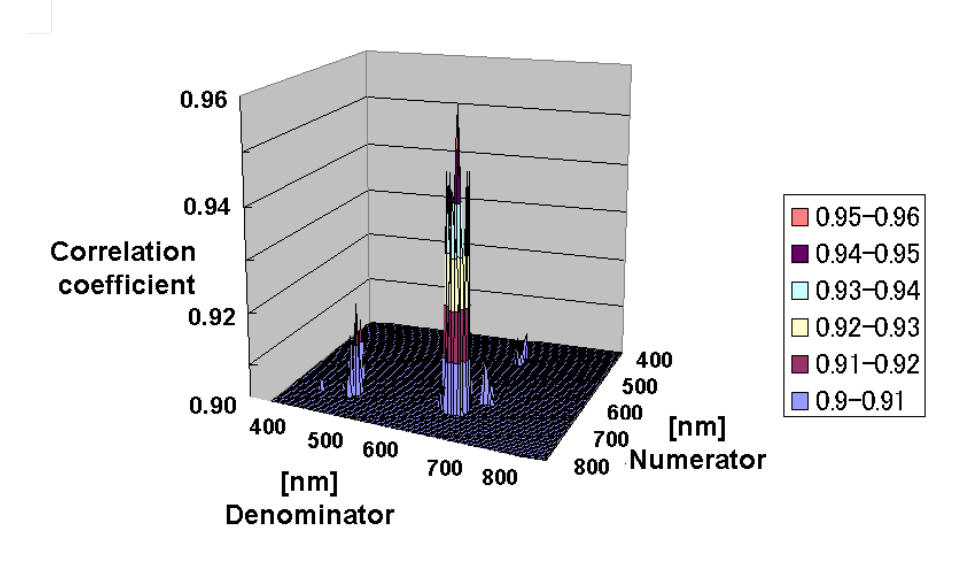
Figure 4. Distribution of correlation coefficient in the three dimensional